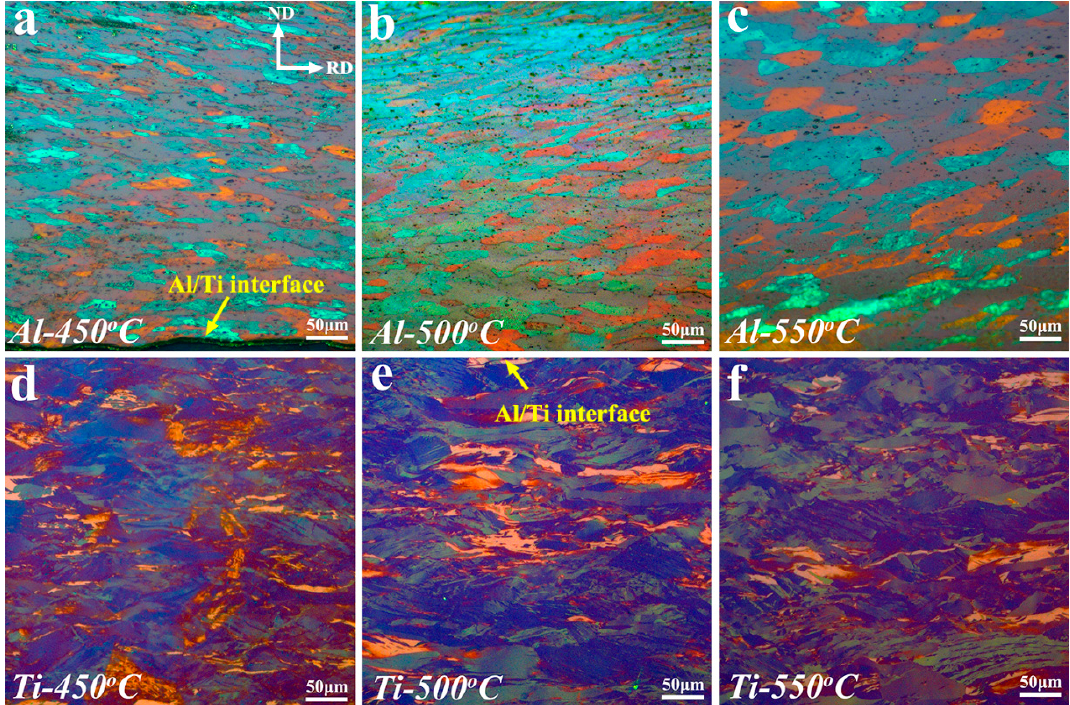
Figure 5. OM micrographs of Al layer and Ti layer of LMCs undergoing pre-rolling diffusion process: ( a , d ) diffused at 450 °C; ( b , e ) diffused at 500 °C; ( c , f ) diffused at 550 °C.